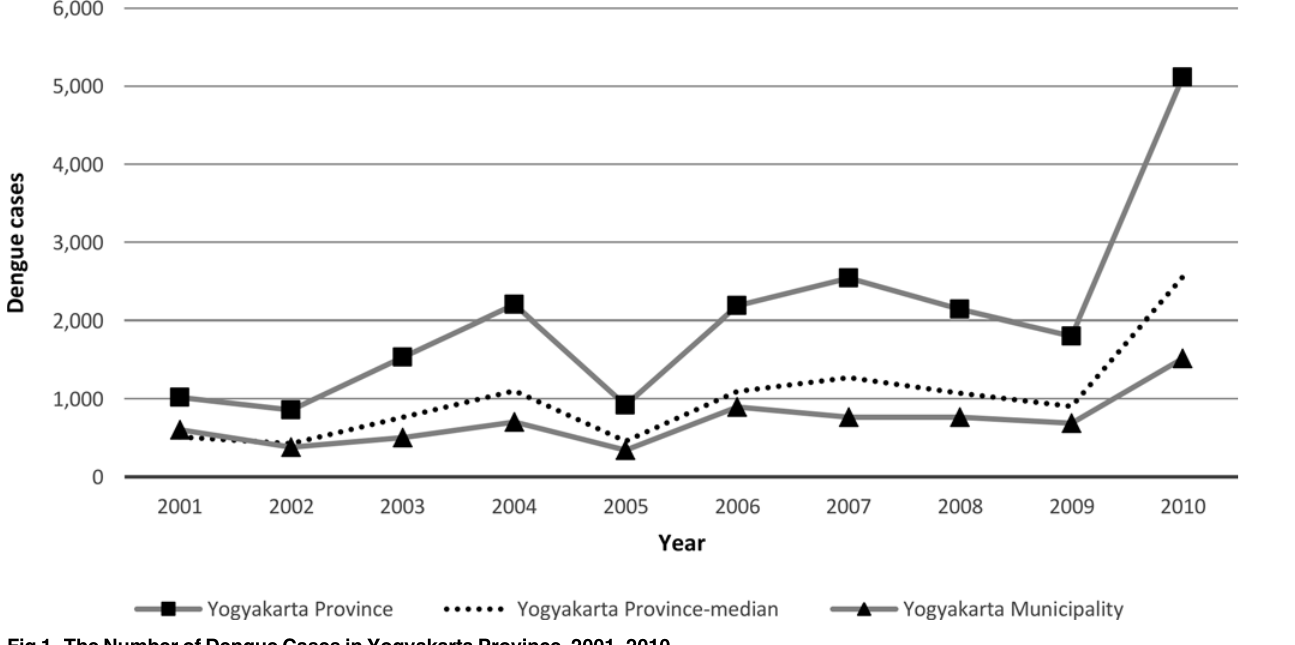
Fig 1. The Number of Dengue Cases in Yogyakarta Province, 2001 –